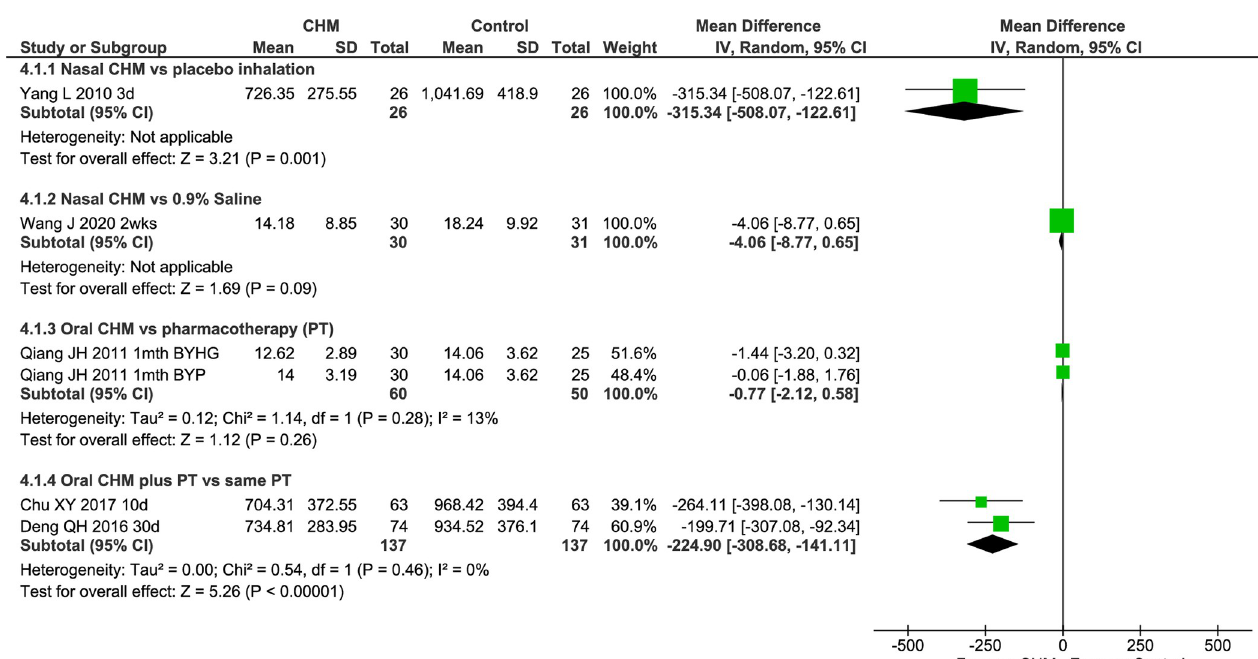
Fig 6. Forest plot of CHM for CRS at end of treatment for MTT. Abbreviations: CHM: Chinese herbal medicine; CRS: chronic rhinosinusitis; d: days; mth: month; MTT: Mucociliary transport time; PT: pharmacotherapy; vs: versus; wks: weeks.